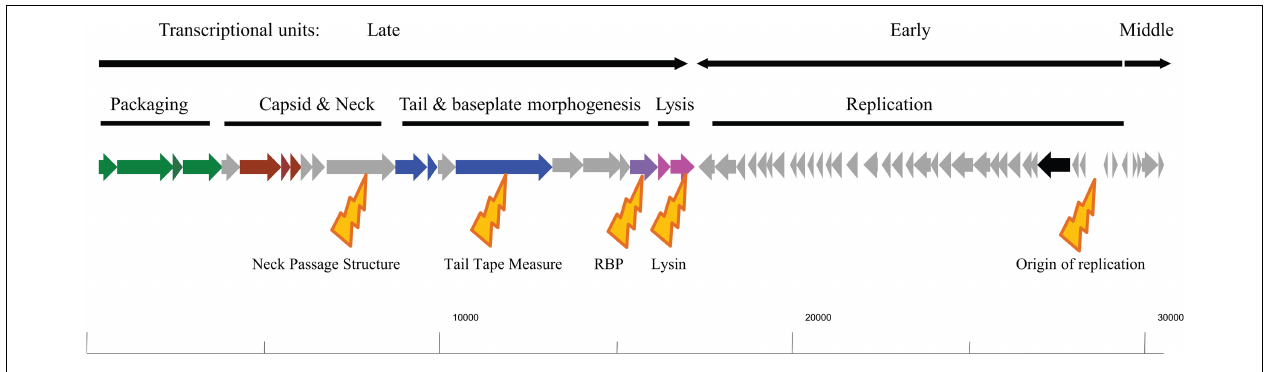
above the genomic drawing as are the functional modules of the genome. Below the genomic drawing are yellow highlighters of the dominant points of divergence in the genomes of the 936 phages: the neck passage structure, the tail tape measure, the receptor binding protein, lysin, and the origin of replication, notwithstanding that a general divergence is observed in the replication module in general.The indicated scale at the bottom of the figure represents base numbering starting at the cos